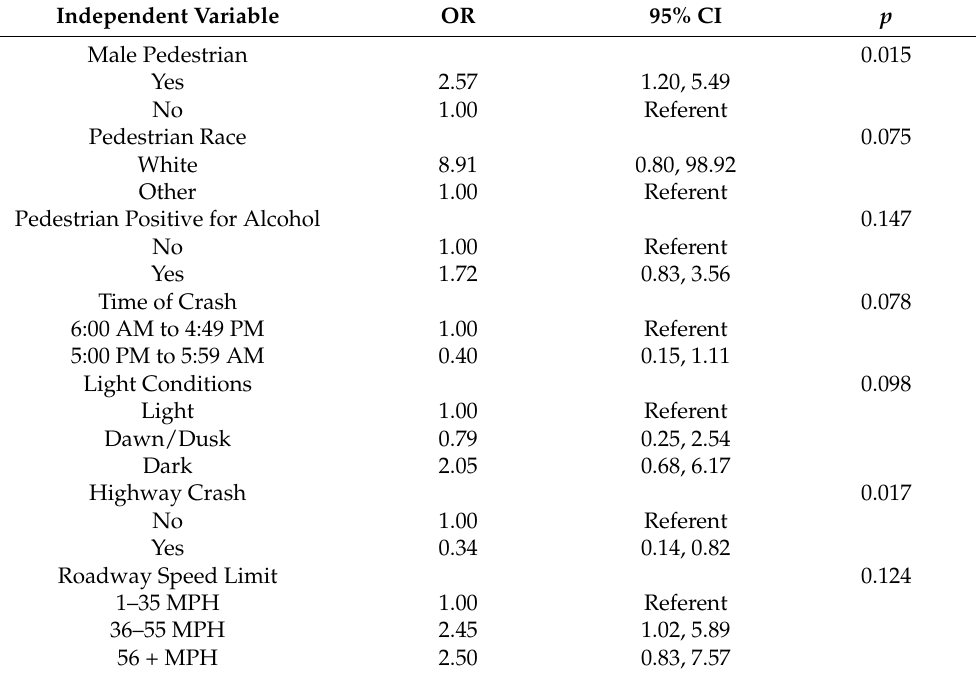
Table 2. Factors that predict rural vs. urban fatal, pedestrian, motor vehicle crashes in West Virginia, 2009–2019